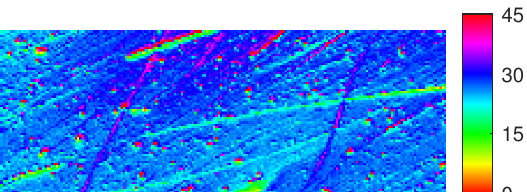
Figure 13. Close-up of a dry fibre component. The width of this image corresponds to approximately 15 mm.